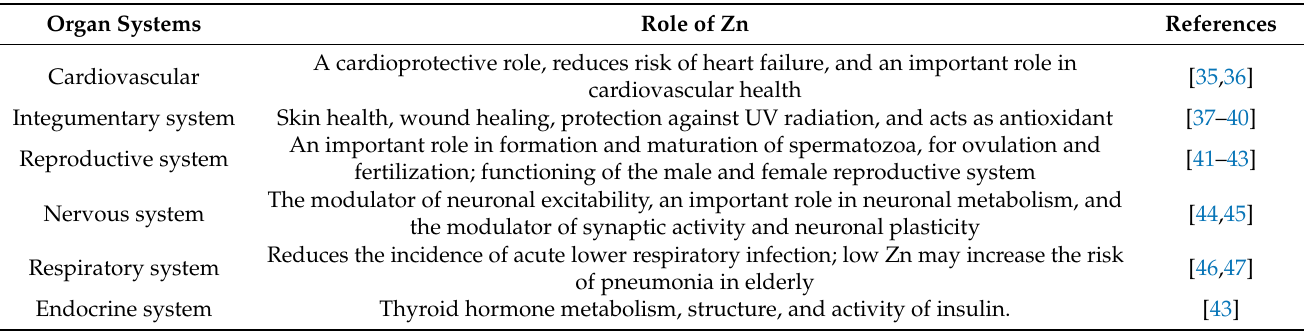
Table 1. Role of Zn in different organ